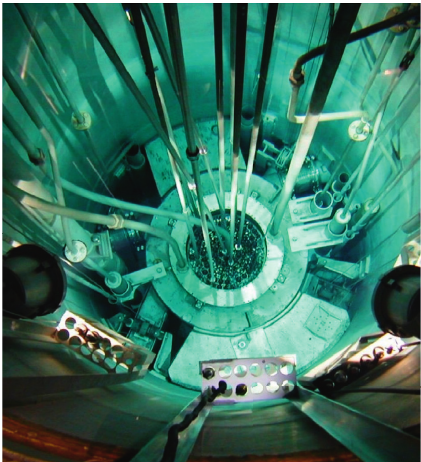
Figure 3: Device performance simulation for water with k � 0.05m − 1 : the green curve represents noncontaminated water and red curve represents contaminated water, and TID � 1MGy.